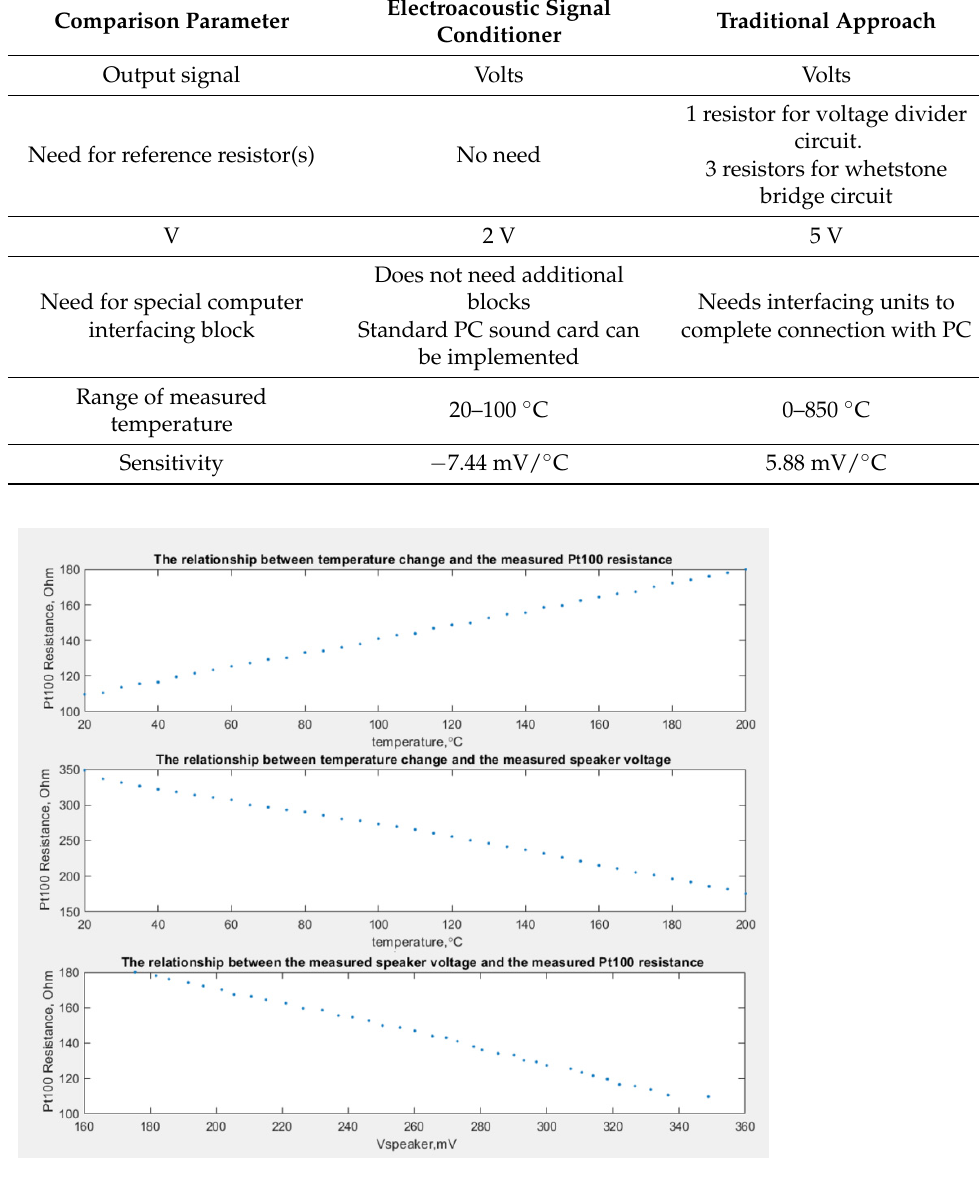
Figure 7. Plots between the temperature change, the measured Pt100 resistance and the measured speaker voltage.